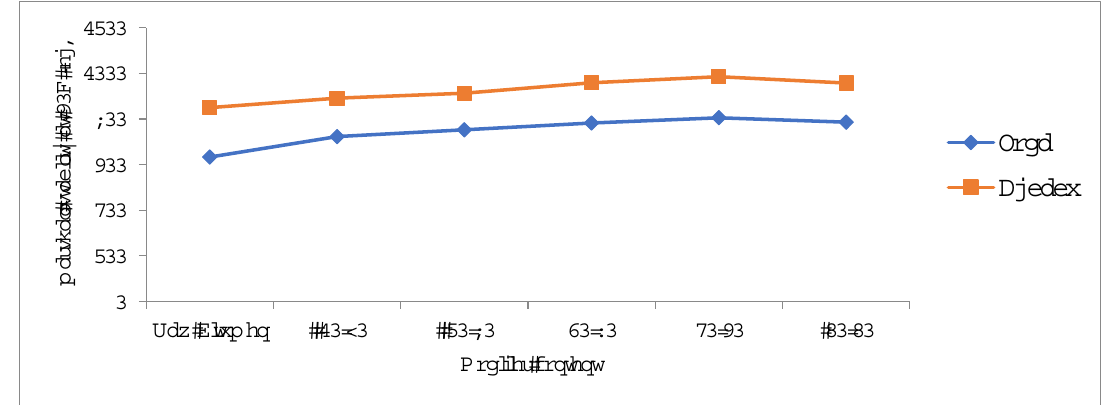
Fig. 9: Marshall Stability in raw bitumen and modifier content Table 2: Result of Rheological Properties of Shredded Tier Modified Bitumen (STMB) from Agbabu.